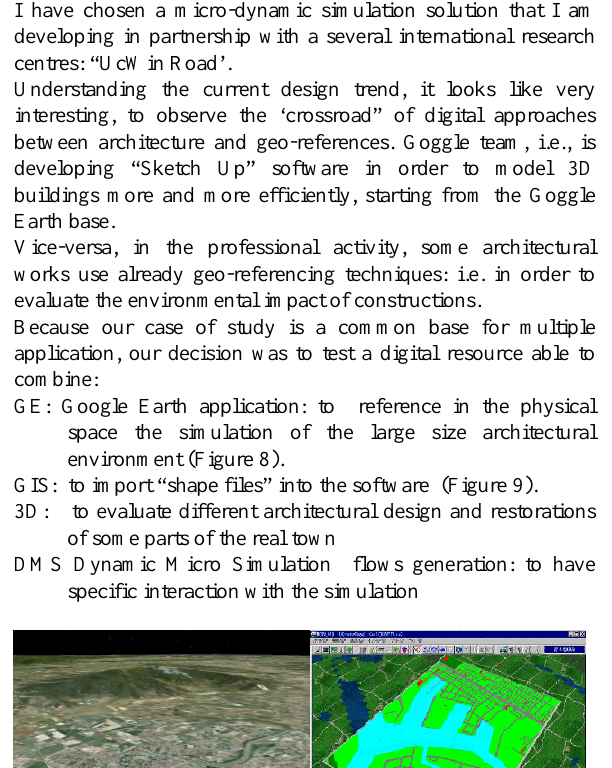
Figure 10. Dynamic Micro Simulation